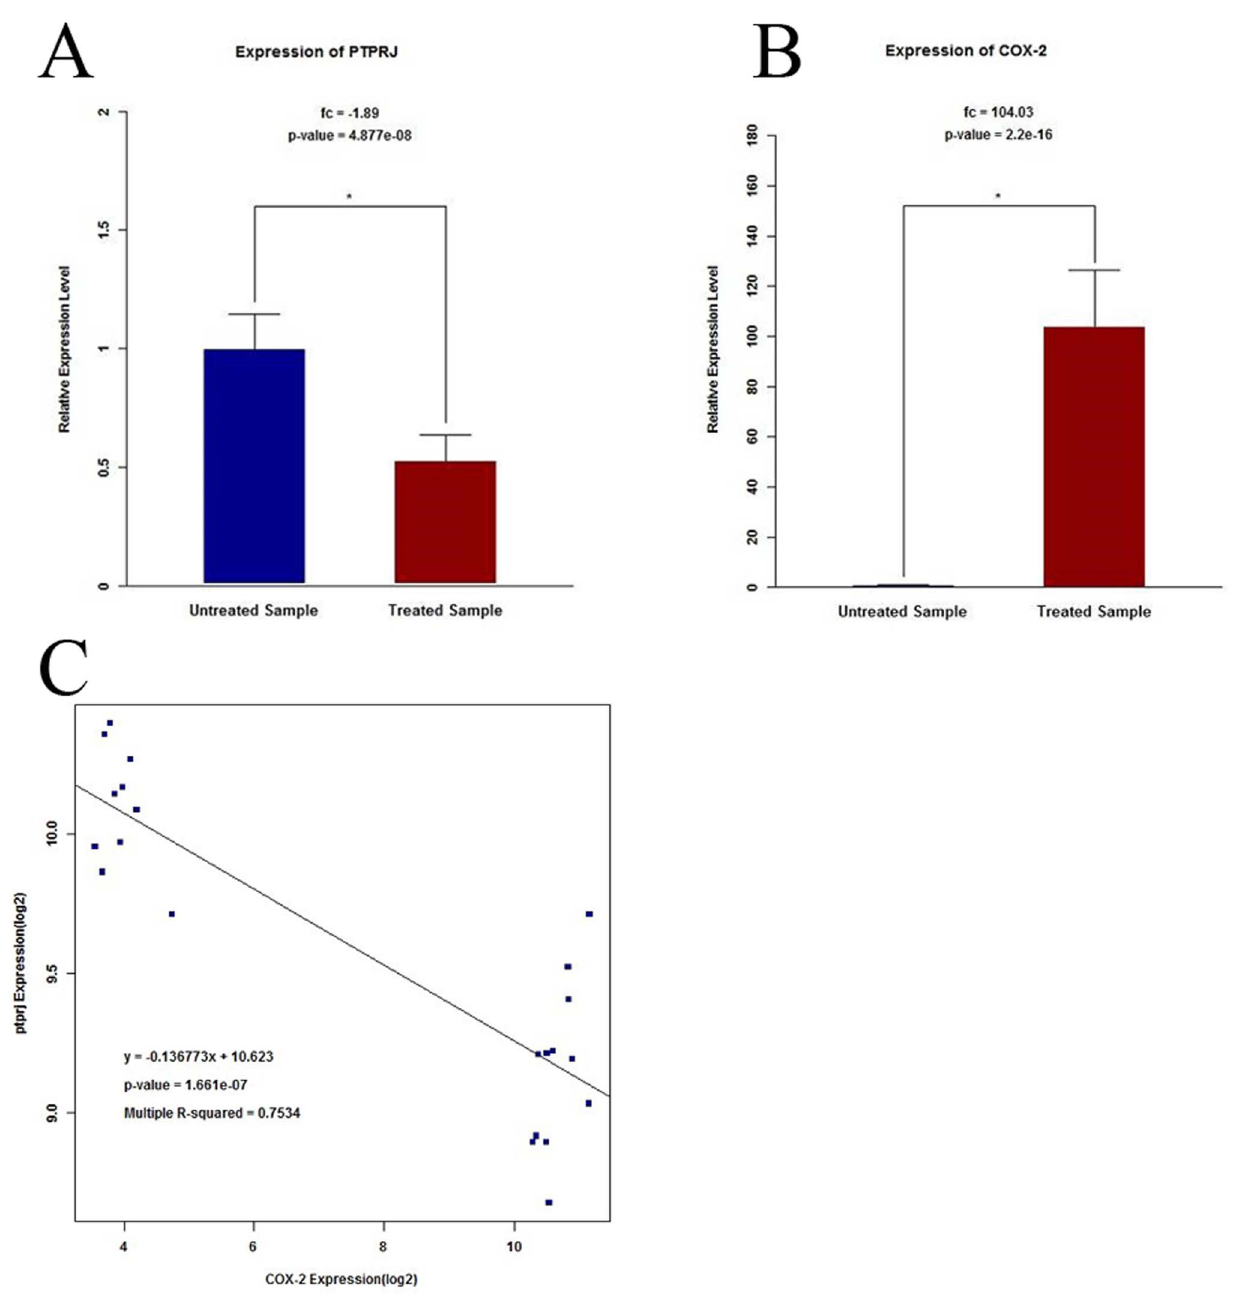
Fig. 1. The correlation of COX-2 and PTPRJ expression in aortic endothelial cells from whole-genome array expression analysis GSE39264. (A) Differential expression of PTPRJ from analysis of a MAEC whole-genome array. *P , 0.05 versus untreated group. (B) Differential expression of COX-2 from analysis of a MAEC whole-genome array. *P , 0.05 versus untreated group. (C) Correlation of COX-2 and PTPRJ expression from analysis of a MAEC whole-genome array. (Pearson correlation coefficient, 2 0.87; n 5 22; P , 0.01, two-tailed). Genes were selected from the microarray data using a threshold of 10% FDR (false discovery rate). P values for fold change between untreated and treated MAECs were determined by t -test; P values for fold change were adjusted using Benjamini–Hochberg.